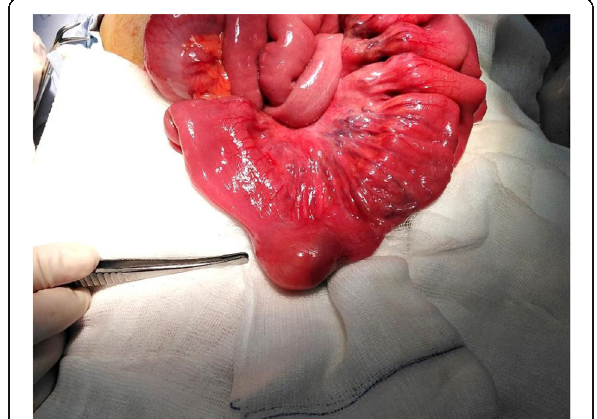
Fig. 4 Pre-operative view of submucosal